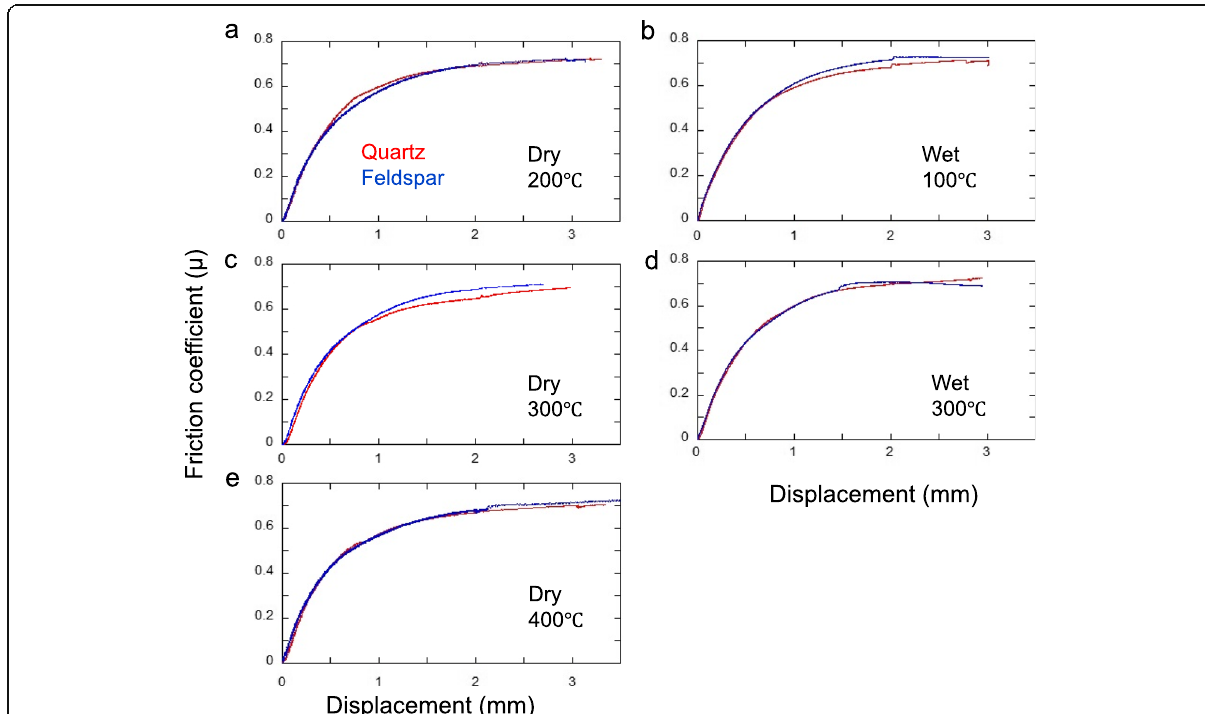
Fig. 3 Examples of the friction curves obtained in our experiments. The friction coefficient, μ , as defined in Eq. (1), is plotted as a function of the displacement of the loading piston for quartz (red curves) and feldspar (blue curves). a Dry samples at 200 °C; b wet samples at 100 °C; c dry samples at 300 °C; d wet samples at 300 °C; e dry samples at 400